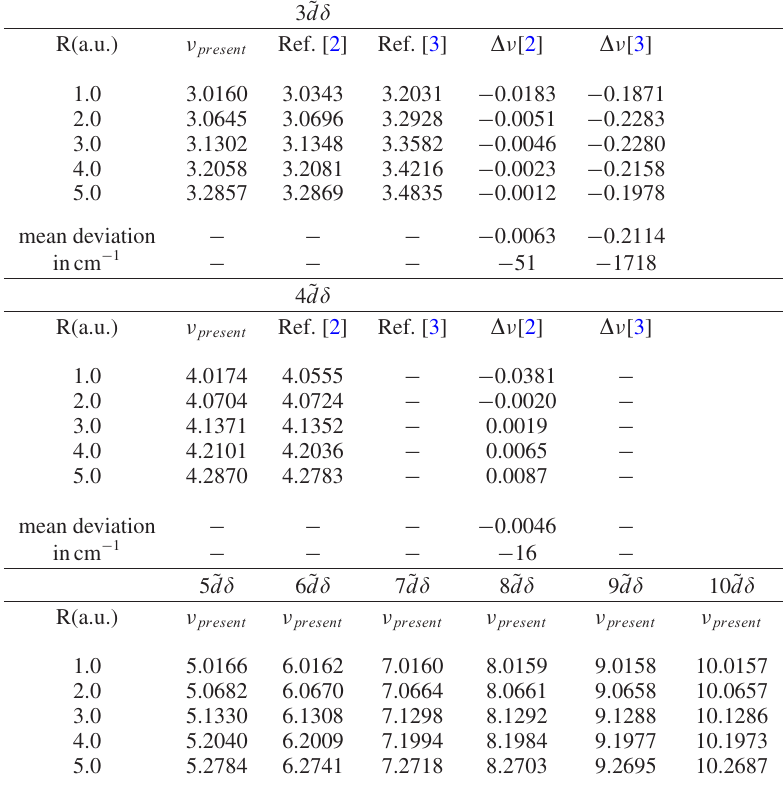
Table 2. Comparison of calculated effective quantum numbers for 3 (cid:1) n ˜ d (cid:5) states of HeH + with those from Refs. [2] and